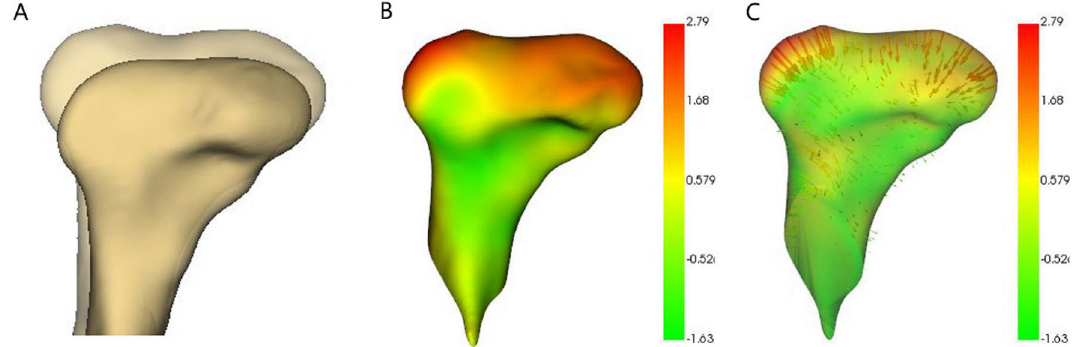
Figure 6. Evaluation methods. ( A ) Semi-transparent overlay. ( B ) Color map. ( C ) Vector map. Red and green colorations show bone resorption and apposition, respectively, 3D slicer (v. 4.11.0, Slicer, http:// www. slicer.